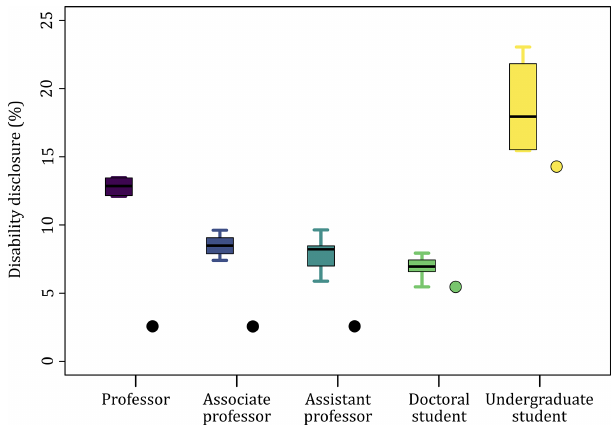
Figure 2. Disability disclosure for physical scientists by senior- ity. Boxplots show disability disclosure rates for seven disciplines within physical sciences for universities and colleges within the United States. United States data from NCSES (2019a) (propor- tion of students who enrolled in 2016 and disclosed a disability), NCSES (2019b) (proportion of individuals who received a doctoral degree in 2017) and NCSES (2019c) (proportion of academic staff who were employed in universities and 4-year colleges in 2017 and disclosed a disability). Circles show the most equivalent UK data, presented as averages for physical sciences (undergraduate and doc- toral students, data from HESA, 2019b), or mathematical, biolog- ical and physical sciences (data from HESA, 2019c). We do not distinguish between disability disclosure rates for academic staff with different seniority within the UK. Some differences in disclo- sure rates between countries are attributed to differences in data collection. Undergraduate students (the proportion of students en- rolling in 2016 who disclose any disability) are the most likely to disclose a disability. For the United States, disclosure rates then in- crease with seniority from doctoral students through to professor, whereas for the UK disability disclosure rates for academic staff are significantly lower than for